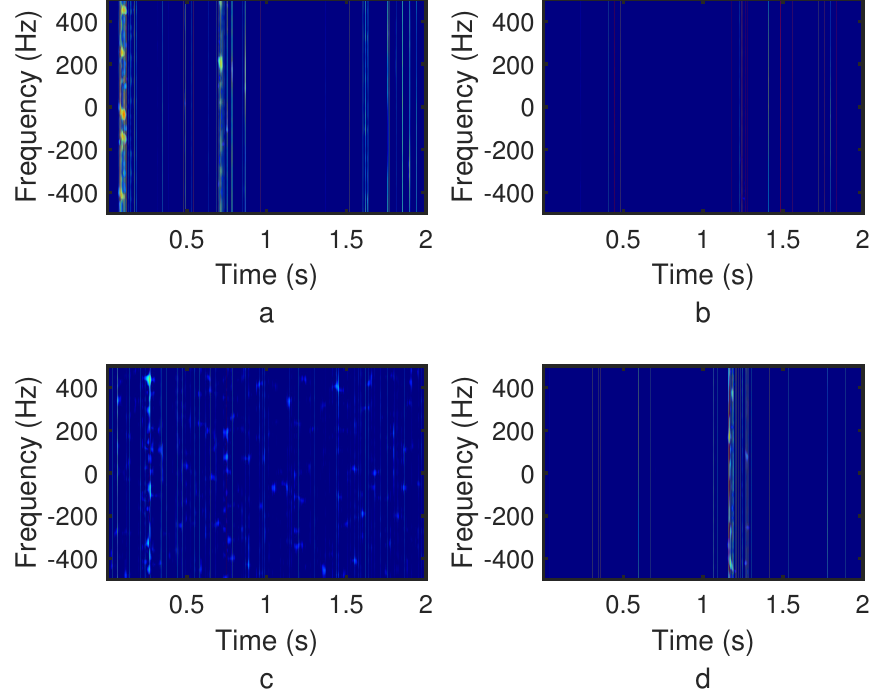
Figure 1. This figure displays the Choi-Williams distribution time-frequency images of the measured WiFi signal regarding ( a ) the marching-in-place exercise, ( b ) rope skipping, ( c ) arms rotating, and ( d ) idle.